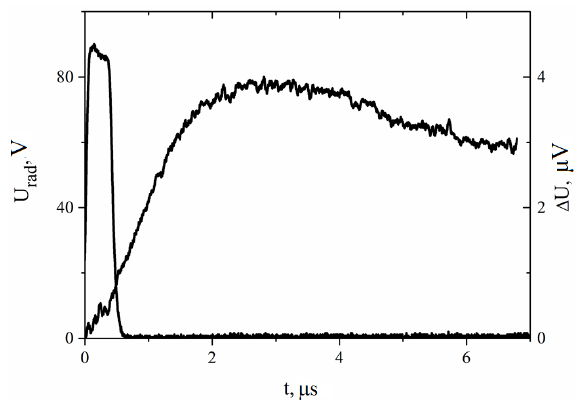
µ s, applied to BB rad = 90 V, duration 0.4